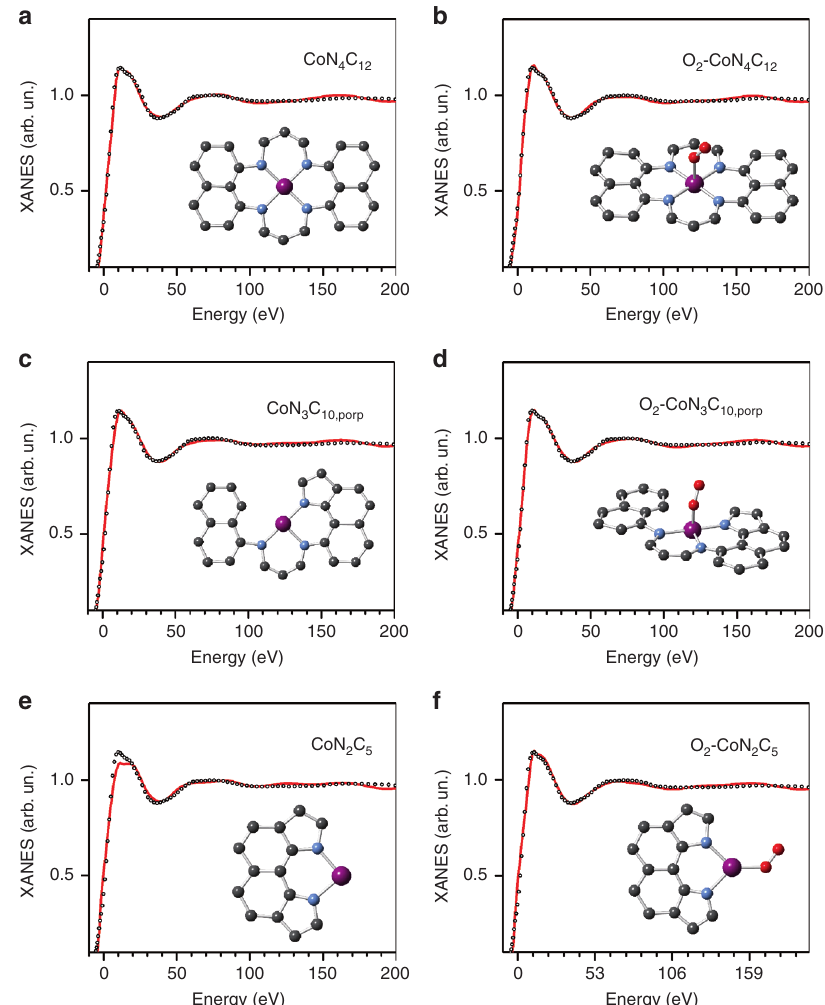
Fig. 3 Experiment versus theory. a-f Comparison between the K-edge XANES experimental spectrum of Co 0.5 (black hollow circles) and the theoretical spectrum calculated with the depicted structures (solid red lines). Cobalt, nitrogen, oxygen and carbon atoms are represented in purple, blue, red and gray,